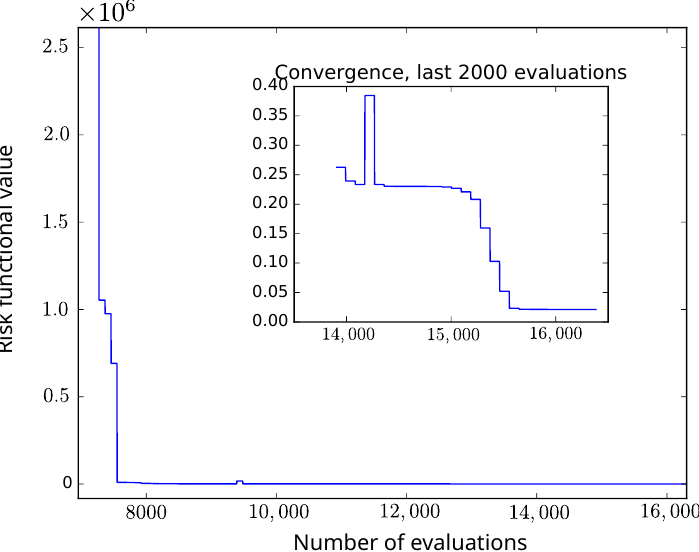
Figure 7. Convergence of the BH algorithm for Example 3.